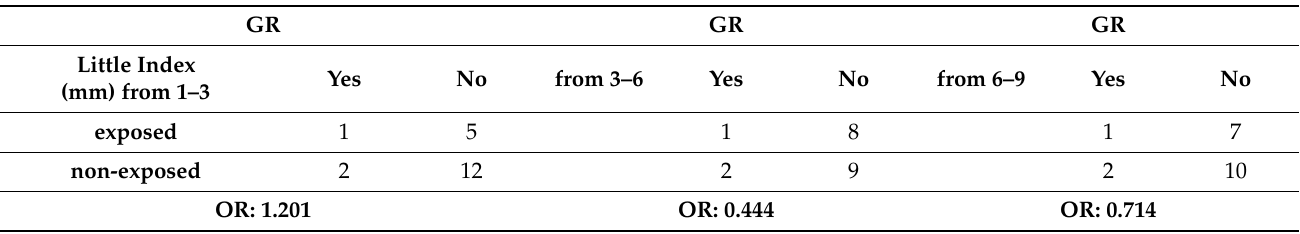
(Table 2). No correlation was shown between incisors inclination and GR (Table 3). Table 3. Little irregularity index and GR.